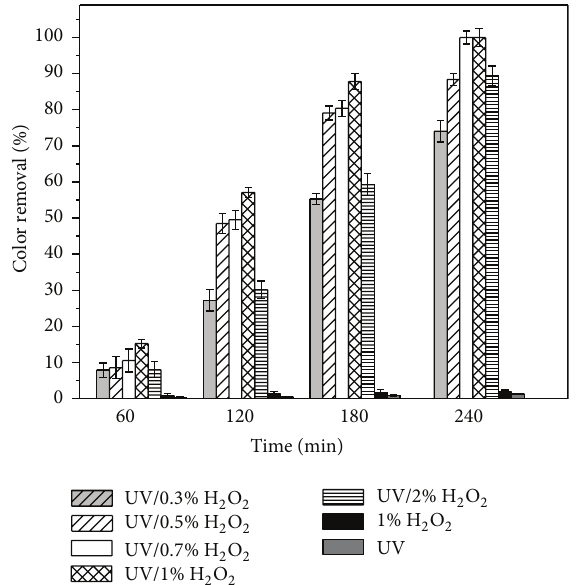
Figure 4: Effect of hydrogen peroxide dosage on color removal. Experimental conditions: 25 ∘ C and initial pH of 10.